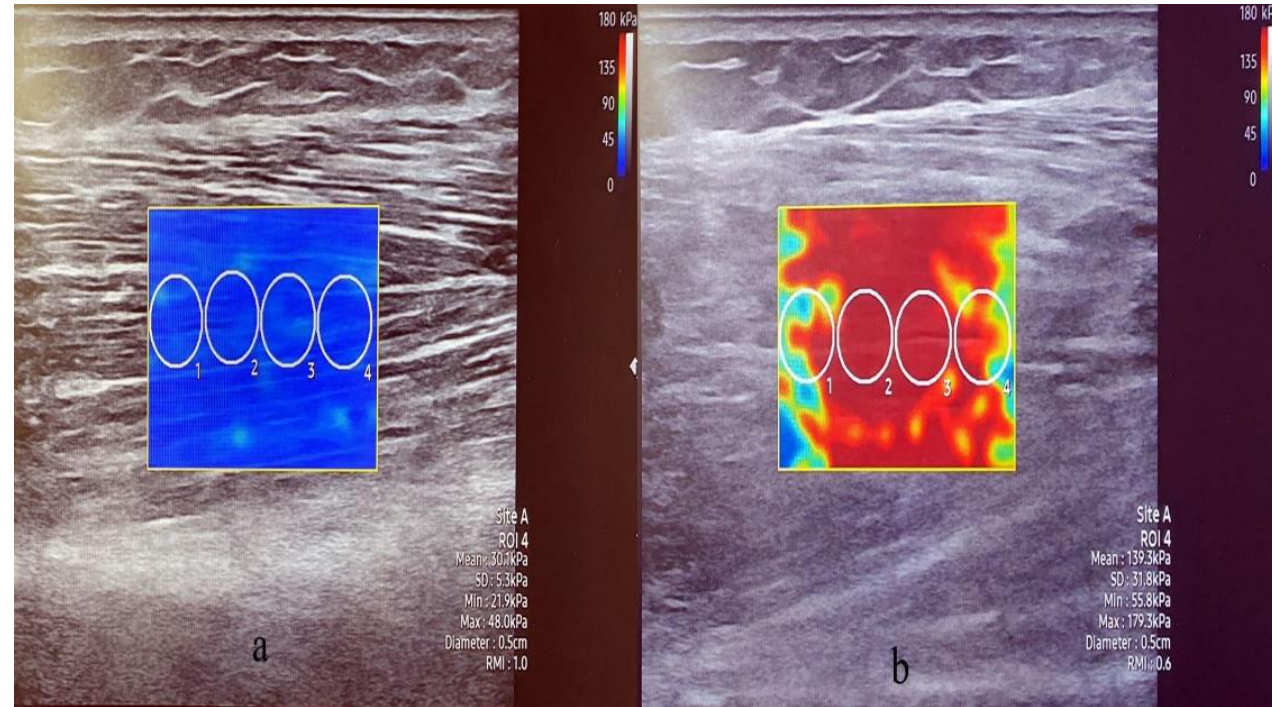
Figure 4. Image of shear wave elastography. The stiffness of medial gastrocnemius was measured under rest state ( a ) and contractive state ( b ). Table 1. Demographic characteristics and health condition of the